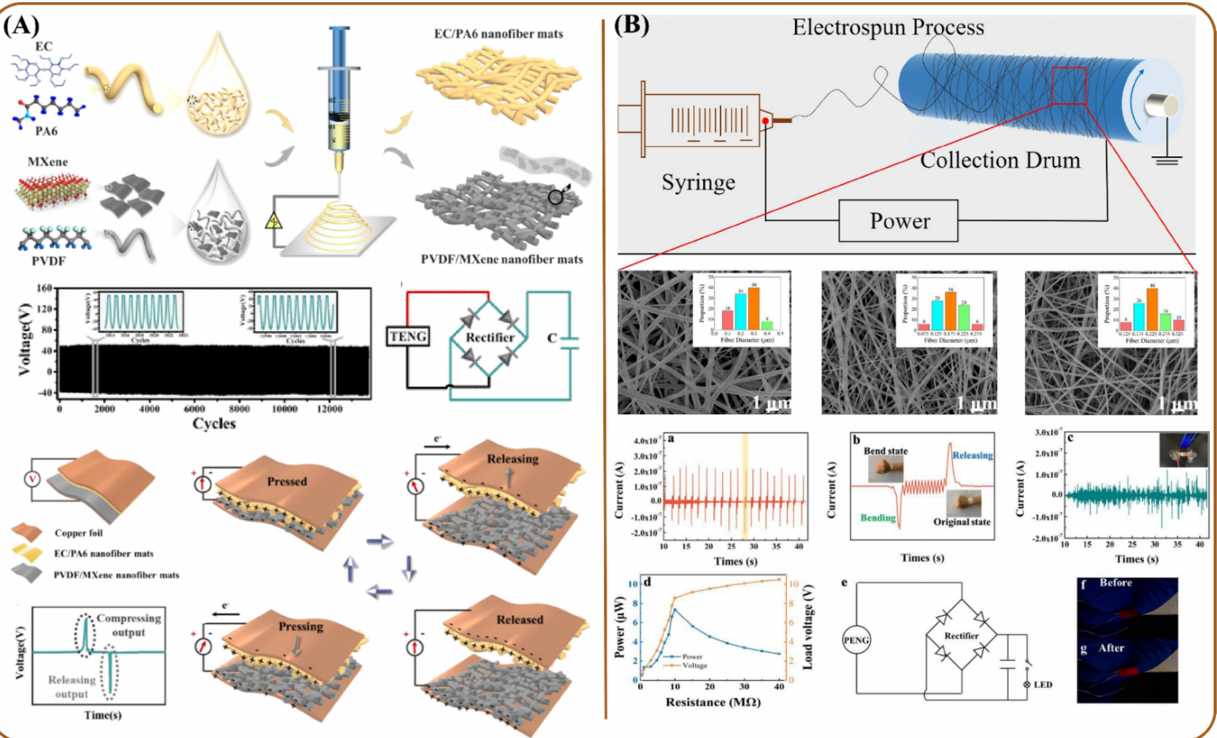
Figure 9. ( A ) Schematic of fabrication process, working mechanism, voltage, and current signals of TENG [186]. ( B ) Illustra- tion of electrospinning system; SEM images and diameter distributions of PVDF fiber, ( a ) Short-circuit current of PENG with 2 wt% rGO under bending conditions. ( b ) One cycle short circuit current generated from the PENG with 2 wt% rGO. The inset shows the PENG with 2 wt% rGO mounted on the wrist with a bending and release gesture. ( c ) Short-circuit current of PENG with 2 wt% rGO under the condition of wind speed as 8 m/s. The illustration shows that the hair dryer continues to blow PENG. ( d ) Load resistance dependence of the output voltage and output power of the 2% rGO/PVDF PENG pressed at 2 Hz frequency. ( e ) Schematic illustration of rectifier circuit. ( f ) Before lighting the bulb. ( g ) The bulb was lighted